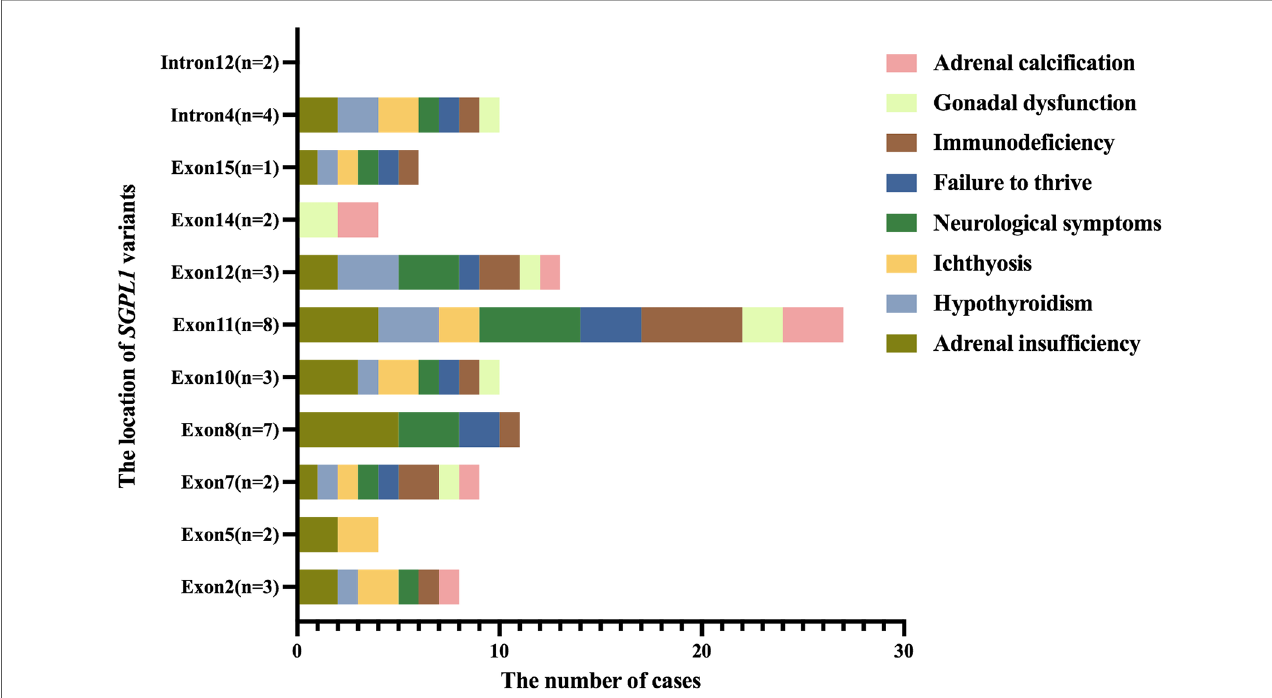
FIGURE 4 The distribution of extra-renal symptoms at the location of SGPL1 variants. While intron12 did not show extra-renal symptoms, introns and exons at other sites did, to varying